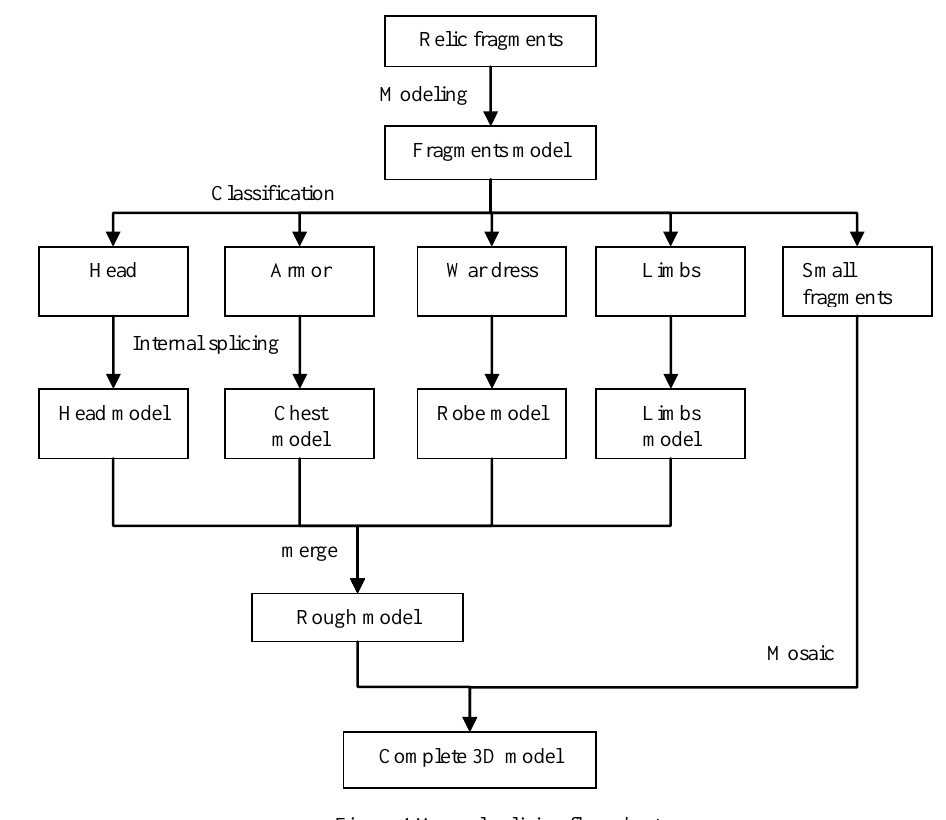
Figure 4 Manual splicing flow